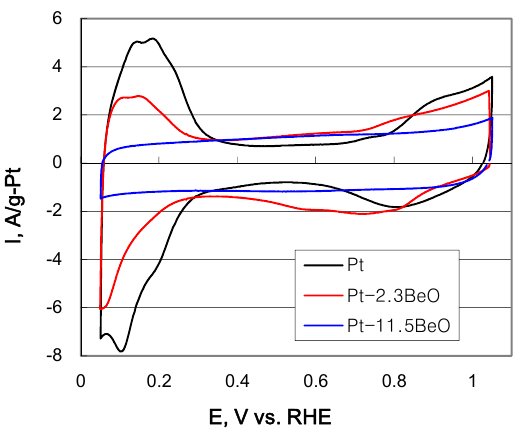
Figure 4. Cyclic voltammogram of carbon ‐ supported Pt–BeO with different amounts of BeO. Table 1. BET specific surface area and electrochemical surface area of Pt and Pt–BeO. Catalyst